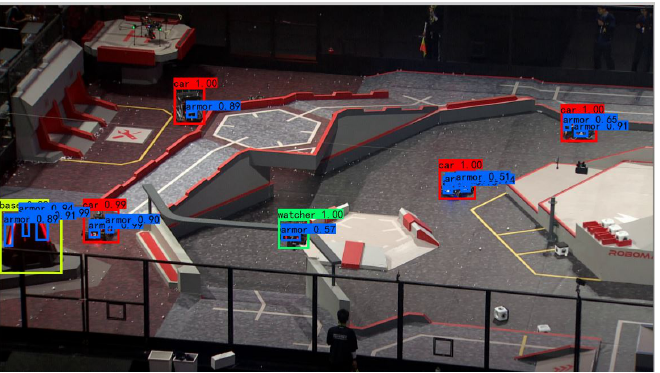
Figure 10. Identification renderings. This figure shows the recognition effect of Figure 9, with rectan- gular boxes and text indicating the objects to be